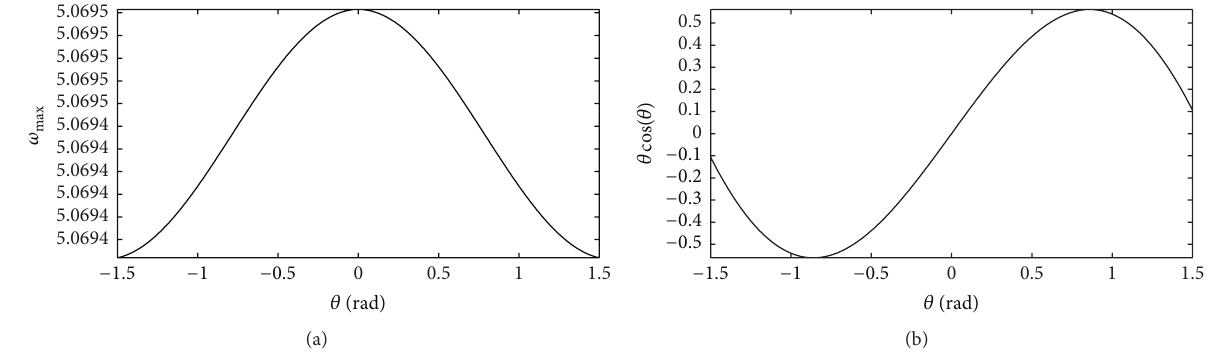
Figure 3: The theoretical limit curves: natural frequency rad/s (a); gyro response rad (b).